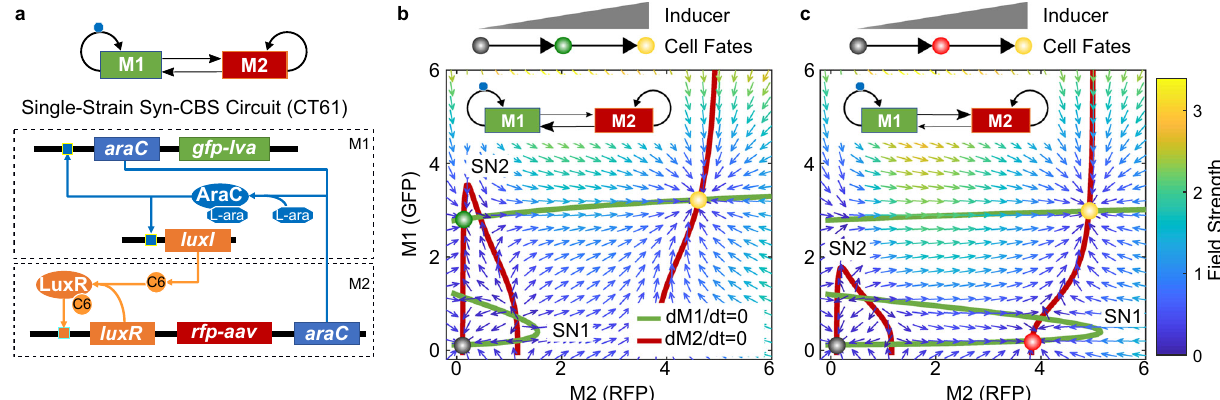
Fig. 1 Conceptual design of the synthetic cascading bistable switches (Syn-CBS) circuit. a Diagram of the Syn-CBS circuit, in which two self-activation modules mutually activate each other. The araC self-activation in Module 1 (M1), regulated by L-ara, is designed to achieve one bistable switch. The luxR self-activation in Module 2 (M2), regulated by C6, is designed to achieve another bistable switch. b , c Phase plane analysis shows the two different expected cell fate transition paths depending on the strength of the links between the two switches. b A weak M1-to-M2 link and a strong M2-to-M1 link lead to a cell fate transition from a RFP-low/GFP-low state (black circle), to a RFP-low/GFP-high state (green circle), and then to a RFP-high/GFP-high state (yellow circle). c A strong M1-to-M2 link and a weak M2-to-M1 link lead to a cell fate transition from a RFP-low/GFP-low state (black circle), to a RFP- high/GFP-low state (red circle), and then to a RFP-high/GFP-high state (yellow circle). The nullclines of M1 and M2 are shown in green and red, respectively. The vector fi eld of the system is represented by small arrows, where the color is proportional to the fi eld strength. The three cell fates are indicated by fi lled circles at the intersections of the two nullclines.